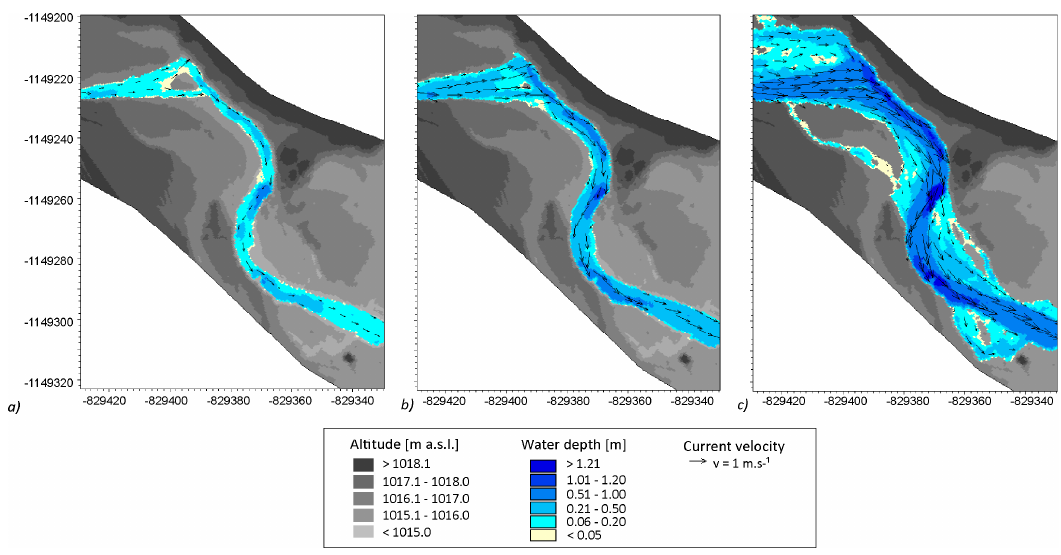
Figure 11. Flood spill, water depth and flow velocity distribution in the analyzed stream segment: ( a ) average flow conditions (0.5 m 3 ·s − 1 ); ( b ) full channel capacity (3.7 m 3 ·s − 1 ); ( c ) peak flow of the June 2013 flood (11.7 m 3 ·s − 1 ).